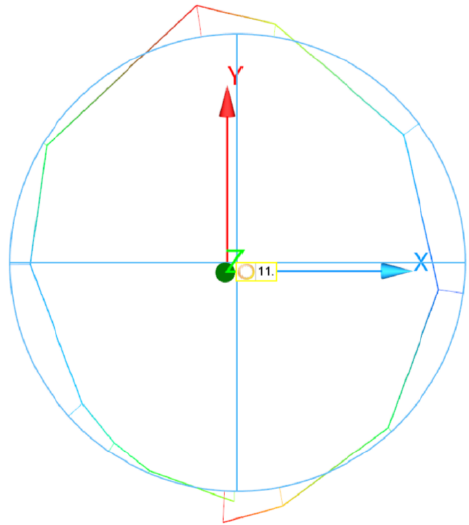
Figure 11. Visualization of measured points, and comparison to the circular shape.